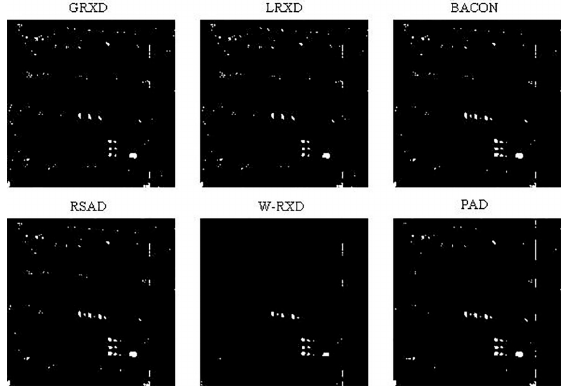
Figure 6. Binary images created after thresholding the results in Figure 5 using empirically selected thresholds. The ratio of anomaly was set to 1%.